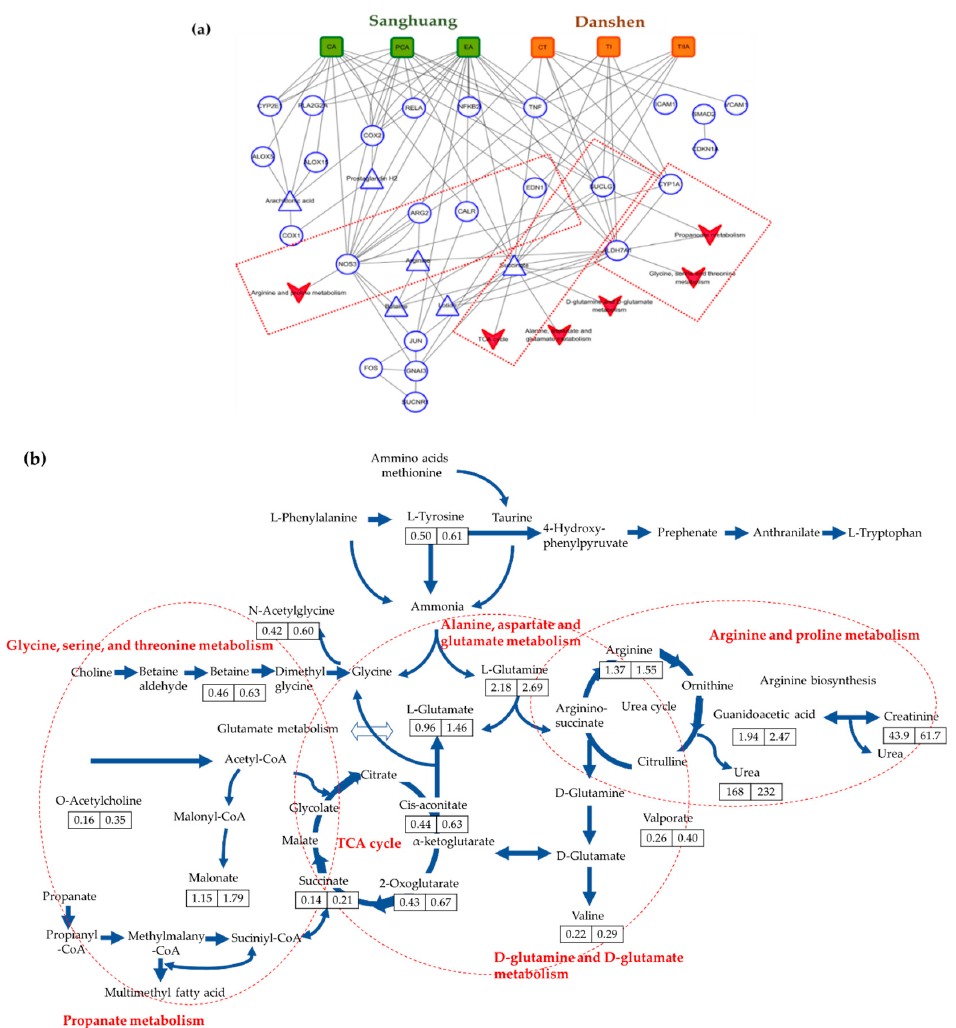
Figure 4. Summary of synergistic mechanisms of SD bioactives in the vascular subnetwork: ( a ) component–target protein (round) or metabolite (triangle)–pathway network ( ); ( b ) complete sequence of six major metabolic pathways. The numbers in the box indicate the level of measured metabolites for the placebo (left) and SD (right) consumption group. SD, Sanghuang–Danshen; CA, caffeic acid; PCA, protocatechuic acid; EA, ellagic acid; CT, cryptotanshinone; TI, tanshinone I; and TIIA, tanshinone IIA. The target protein names are detailed in Table S4 (Supplementary Materials).